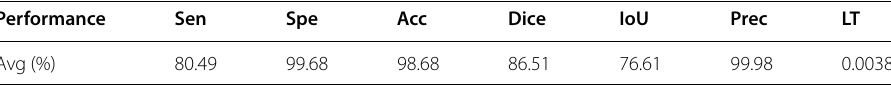
Sen sensitivity, Spe specificity, Acc accuracy, IoU Intersection over Union, Prec precision, LT loss for training data, Avg average